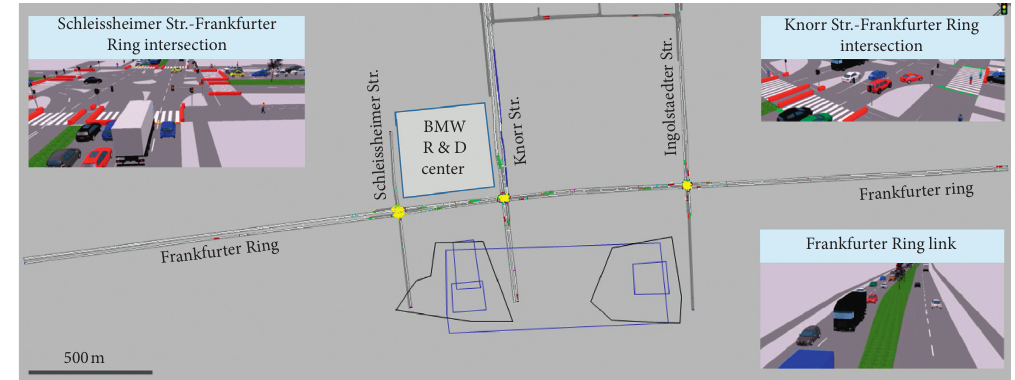
Figure 4: Frankfurter Ring VISSIM